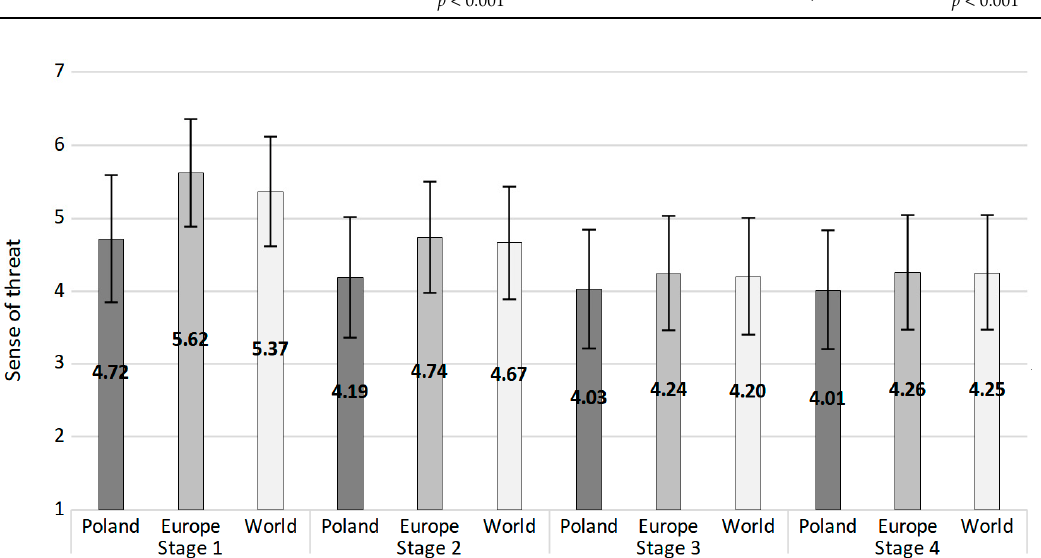
Figure 3. Mean values of sense of threat regarding Poland, Europe, and the whole world in four consecutive research stages. Error bars present standard deviations.